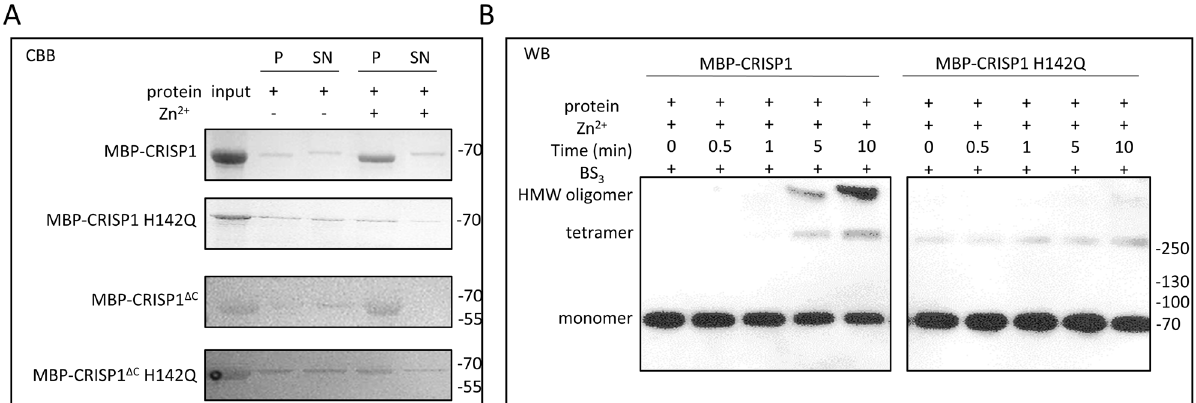
Figure 5. His142 is essential in Zn 2+ -induced human CRISP1 oligomerization. ( A ) 1.5 μM MBP-CRISP1/ MBP-CRISP1 H142Q/MBP-CRISP1 ΔC /MBP-CRISP1 ΔC H142Q was incubated with 1 mM Zn 2+ at 37 °C for 10 min, respectively. The reactions were spun down at 14,000 g for 1 h at 4 °C. The pellet fraction (P) and 1/5 of the supernatant (SN) were analyzed by SDS-PAGE gel and Coomassie Brilliant blue (CBB). ( B ) 1.5 μM MBP- CRISP1/MBP-CRISP1 H142Q was incubated with 1 mM Zn 2+ at 37 °C for 10 min. BS 3 was added in